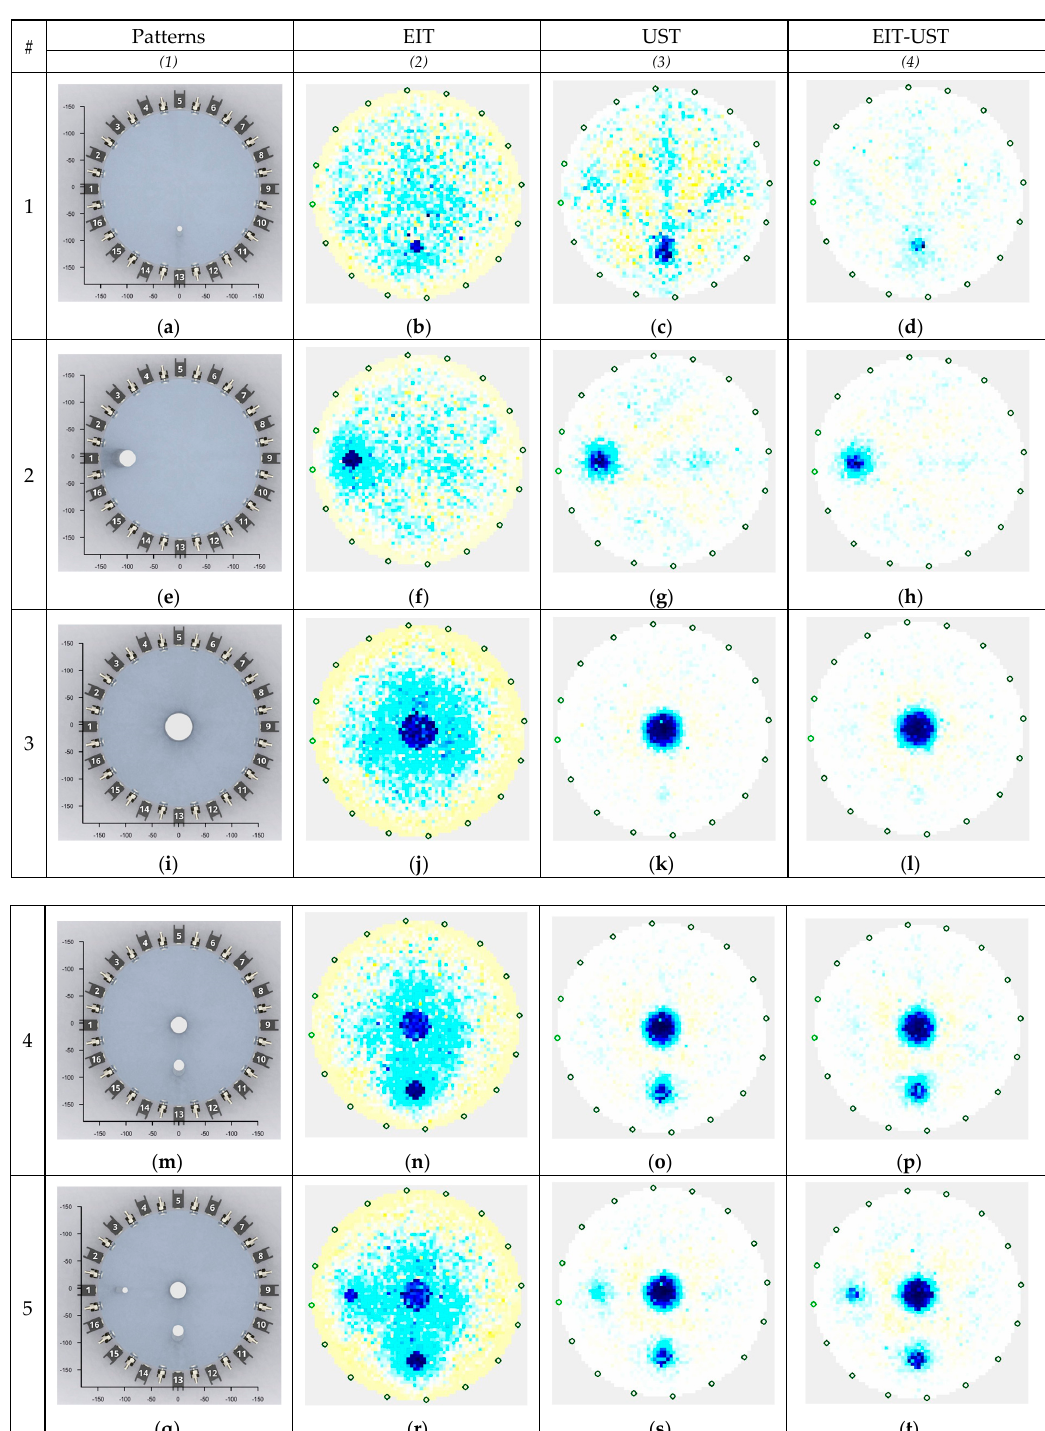
Figure 13. Reconstruction results based on real measurements: ( a,e,i,m,q ) – Patterns; ( b,f,j,n,r ) – EIT; ( c,g,k,o,s ) – UST; ( d,h,l,p,t ) – EIT-UST.